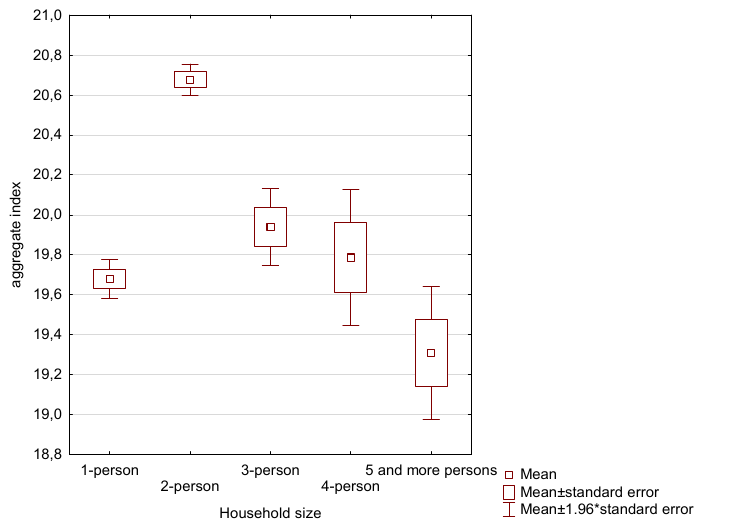
Figure 7. The level of the aggregate indicator in 2018 by household size for households of people aged 60 and older. Source: own elaboration based on data from [136].